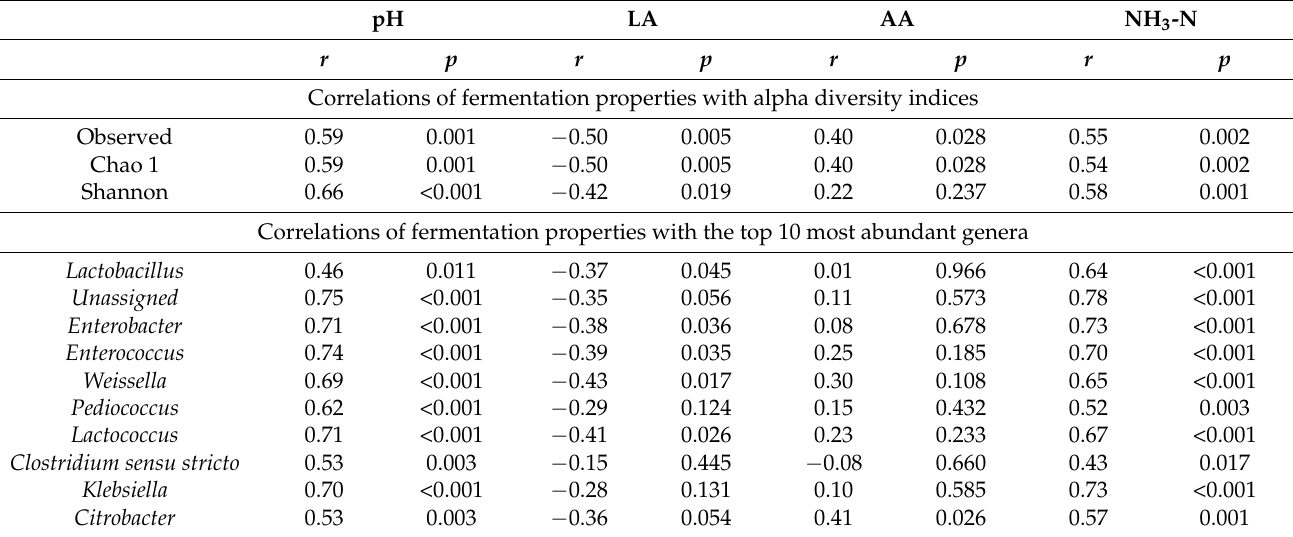
Table 3. Spearman’s correlation analyses of fermentation properties with alpha diversity indices and abundance of the top 10 most abundant